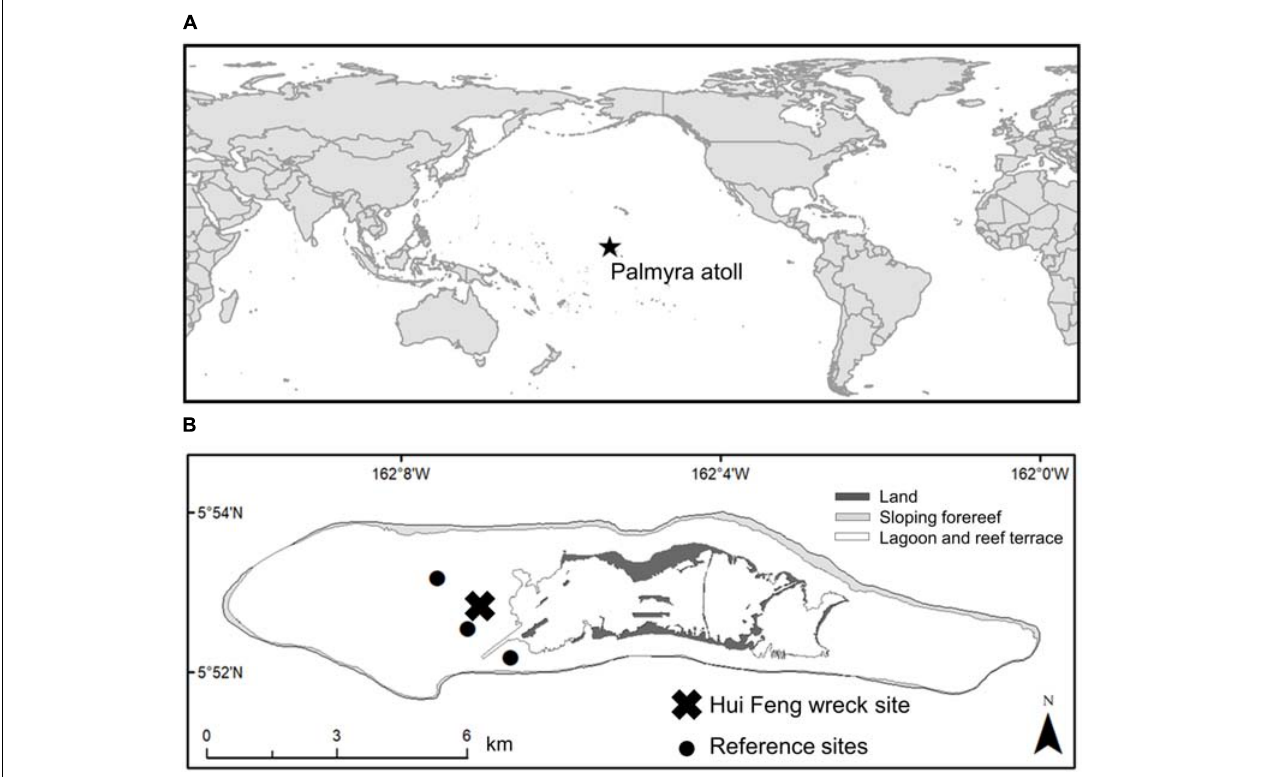
FIGURE 1 | (A) Location of Palmyra atoll in the Pacific Ocean, (B) location of Hui Feng wreck site and reference survey sites on the shallow western terrace and backreef at